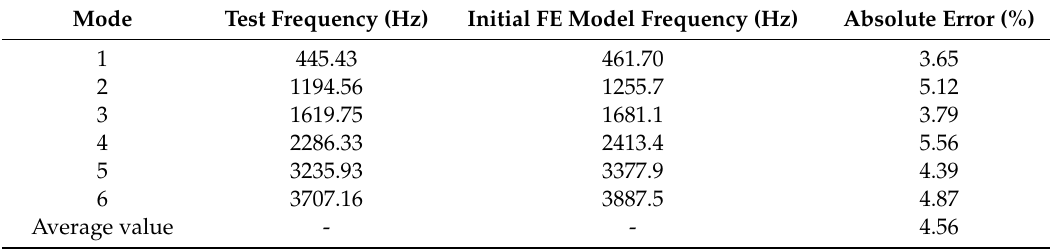
Table 4. The inherent frequencies from test and initial FE